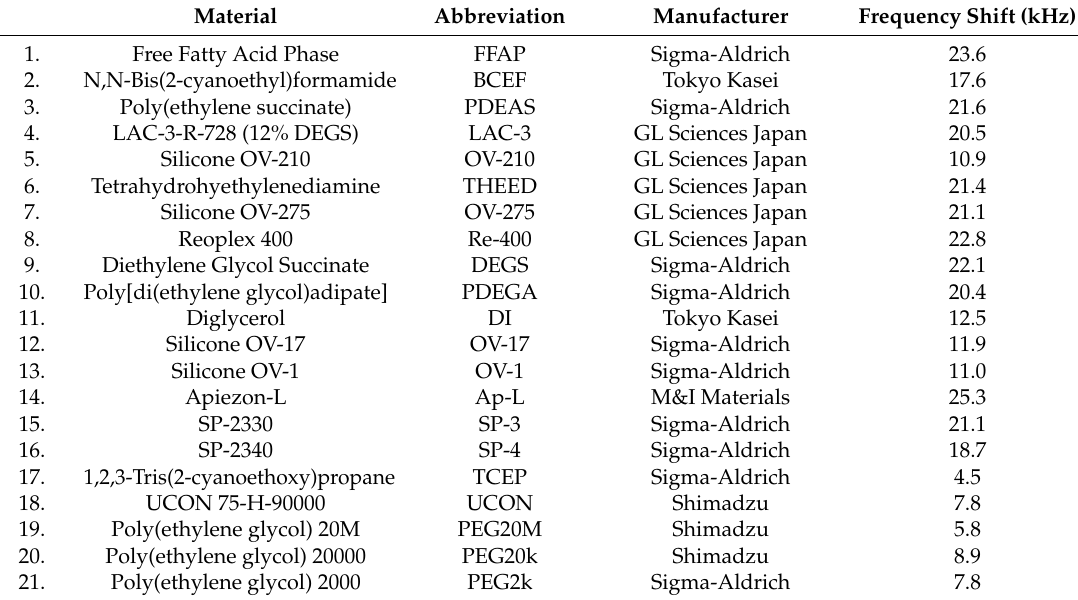
Table 2. Characteristics of the quartz crystal microbalance (QCM) sensors fabricated for the gas chromatography (GC) material